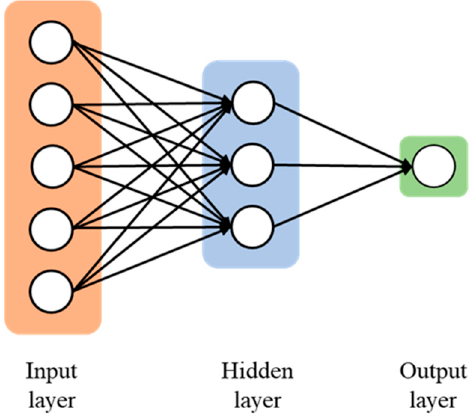
Figure 1. The construction of the artificial neural network (ANN)